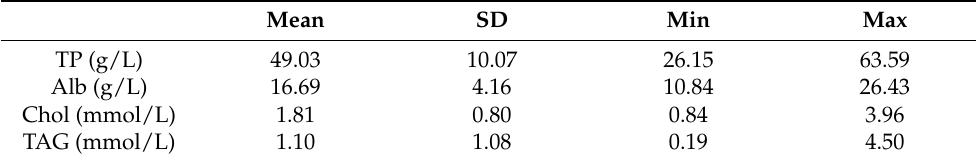
Table 4. Selected biochemical components of bovine seminal